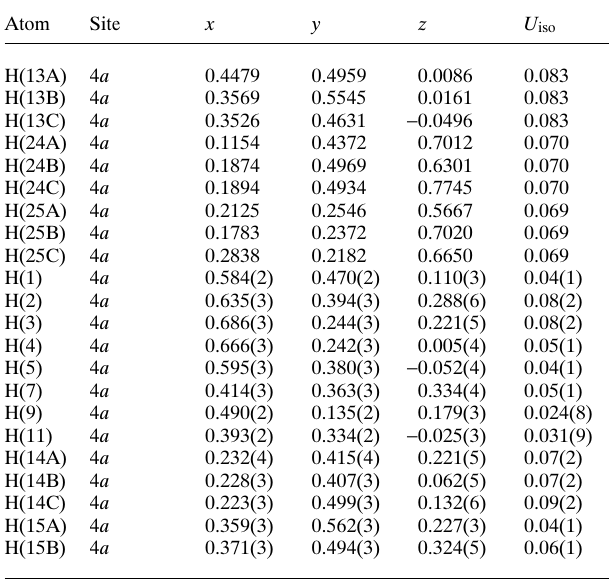
Table 2. Atomic coordinates and displacement parameters (in Å 2 )